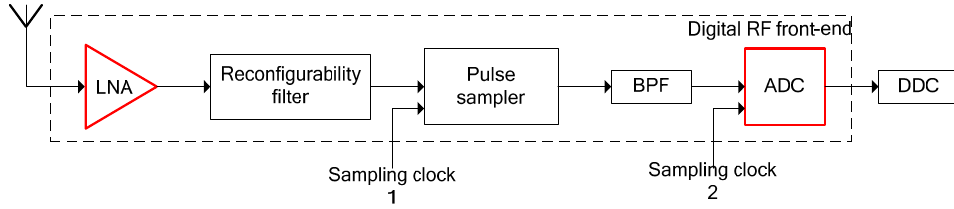
Figure 3. Direct-digitization radio frequency (RF) front-end block diagram highlighting the components that are considered sources of nonlinearity in this paper.